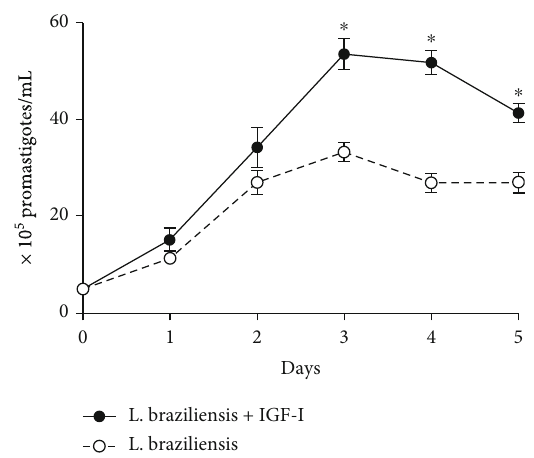
Figure 1: E ff ect of insulin-like growth factor (IGF)-I on Leishmania ( Viannia ) braziliensis promastigote proliferation. In vitro L. braziliensis growth curve in the presence (black circle) or absence (white circle) of 50 ng/mL rIGF-I. Live promastigotes were counted every day for fi ve days. The points represent the mean of the three experiments, and the bars represent standard deviation. ∗ P < 0 : 05